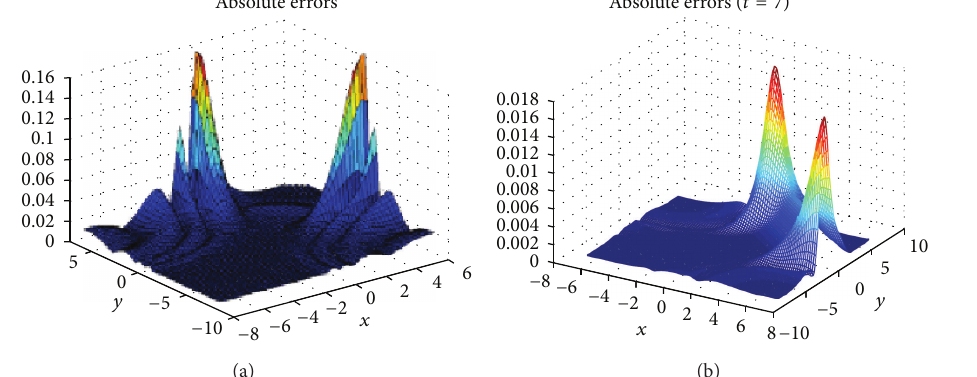
Figure 1: (a) Absolute error of the solution of RBF method [21] and (b) absolute error of the solution of the PC-DFFD scheme in 𝑡 = 7 for test problems